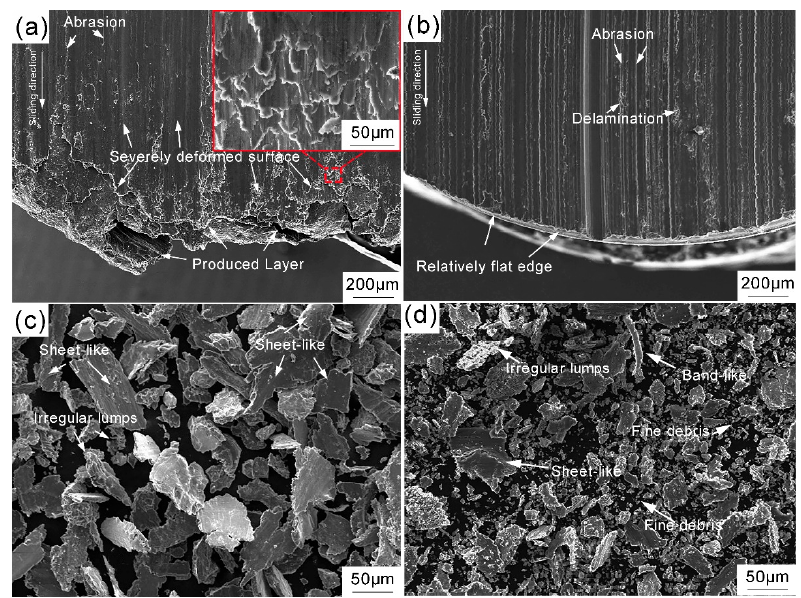
Figure 9. Wear edge morphology and debris morphology of surfacing magnesium alloys under a 100 N load: ( a , c ) AZ91 alloy, ( b , d ) AZ91 + 0.5 Gd alloy.